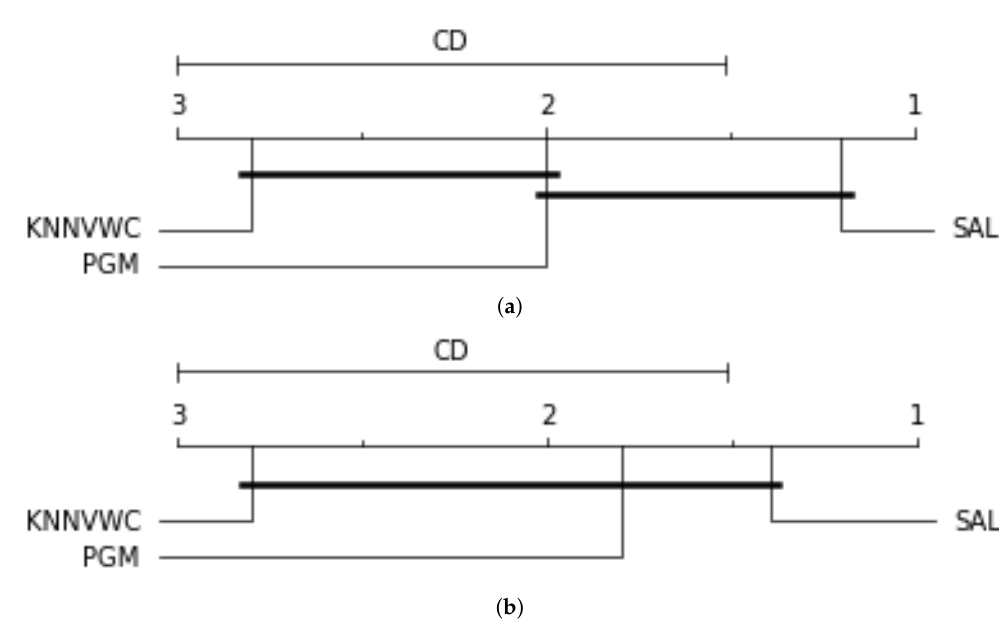
Figure 7. Overall accuracy comparison of the three semi-supervised algorithms on the both datasets using the Friedman–Nemenyi test. ( a ) Overall accuracy on the NSL-KDD dataset. ( b ) Overall accuracy on the ISCX